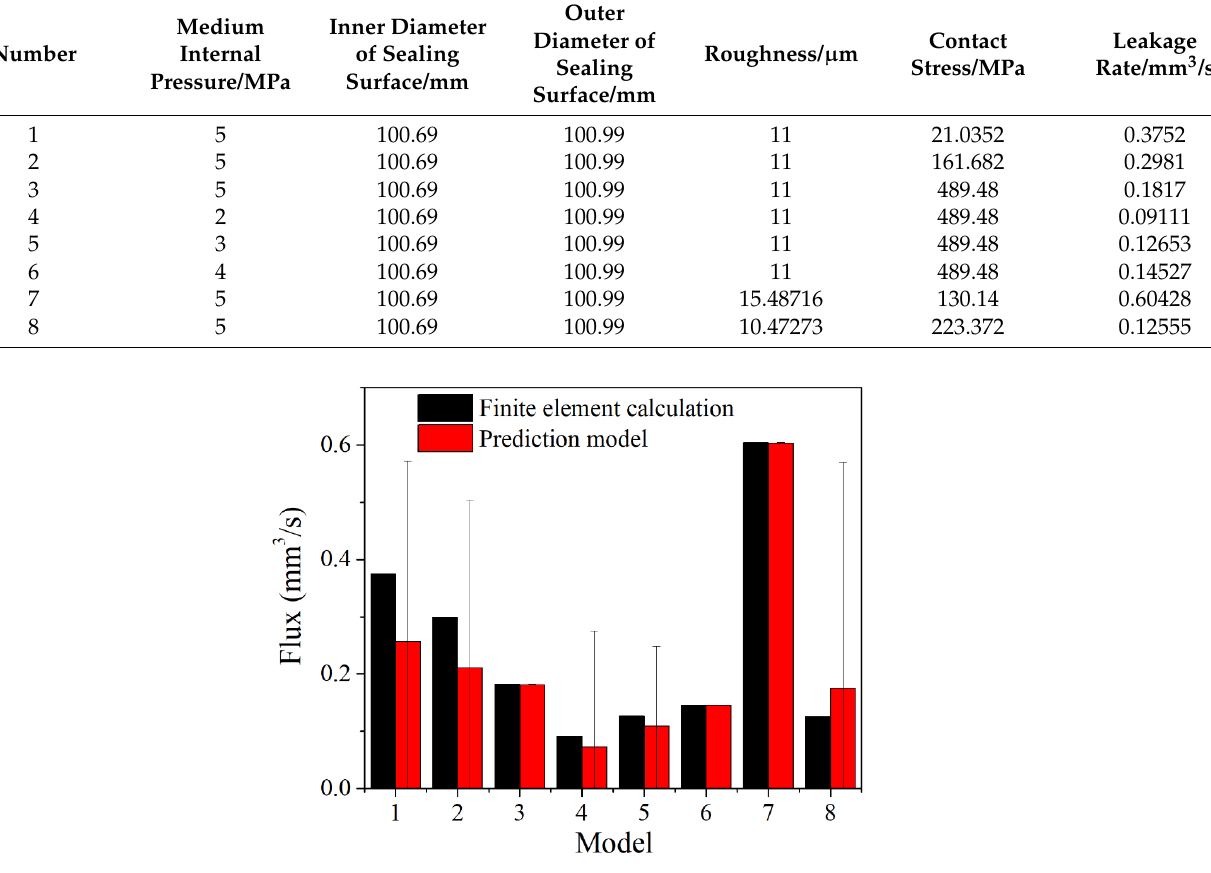
Figure 14. The comparison between calculation results and model prediction results. Table 3. Calculation results of the leakage rate of the NiTi alloy corrugated gasket under different parameters.